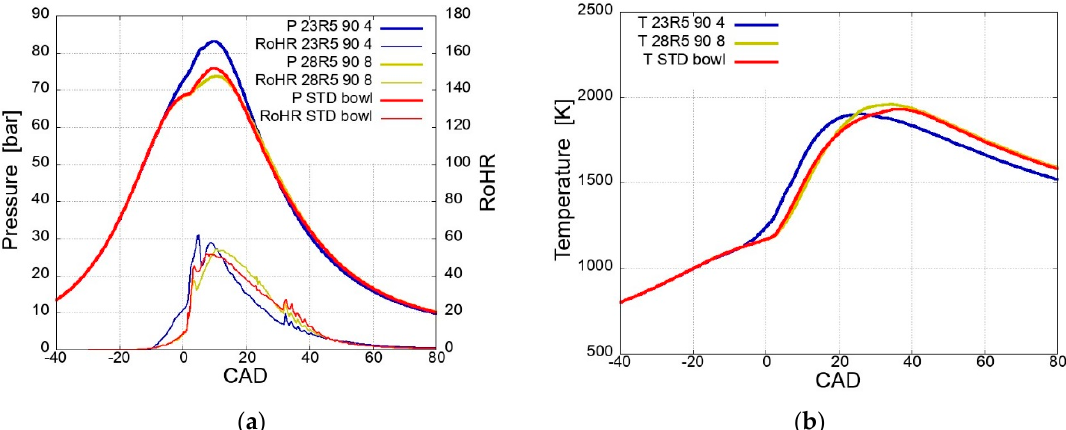
Figure 11. In-cylinder pressure and rate of heat release ( a ) and temperature ( b ) at FL (BMEP = 8 bar, 3000 rpm).